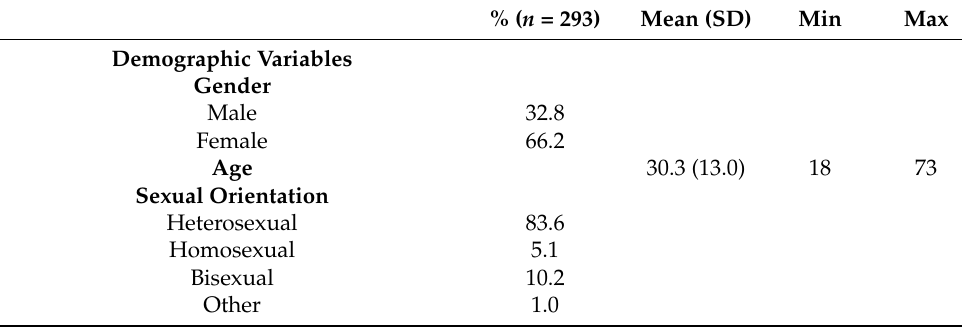
Table 1. Descriptive statistics of demographic and background variables for the